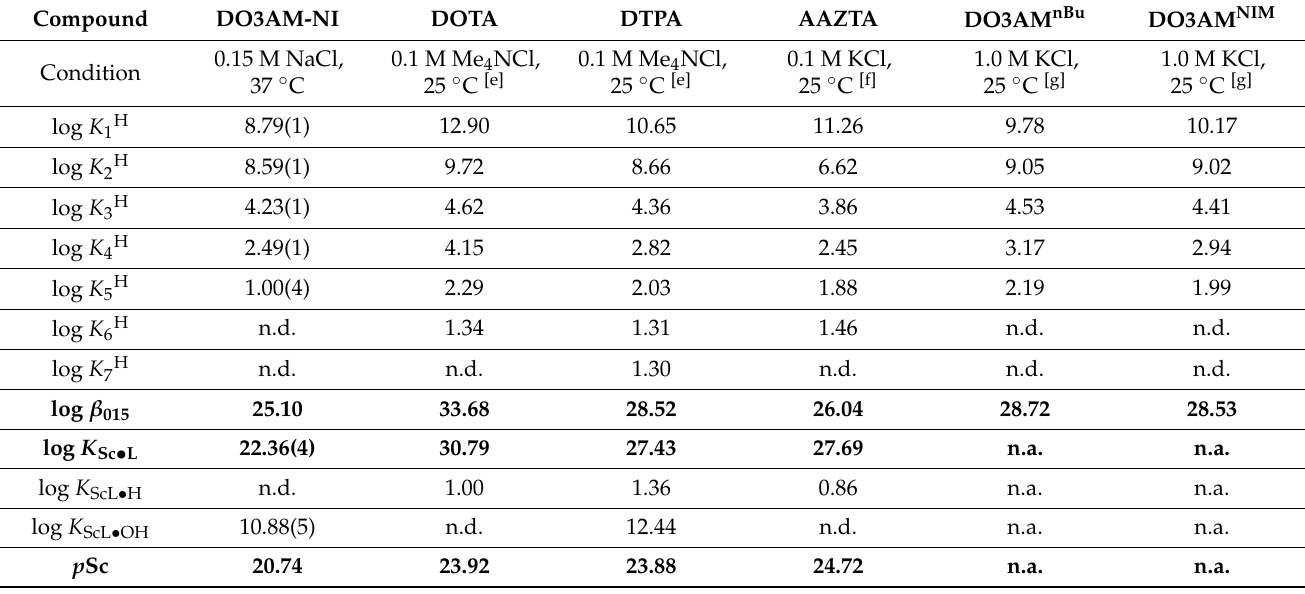
Table 1. Stepwise protonation constants [a] and the sum of the protonation constants [b] of DO3AM-NI and DOTA, DO3AM nBu , DO3AM NIM , DTPA and AAZTA ligands used as comparative benchmarks, stability constants of their Sc(III) complexes [c] as well as p Sc [d]